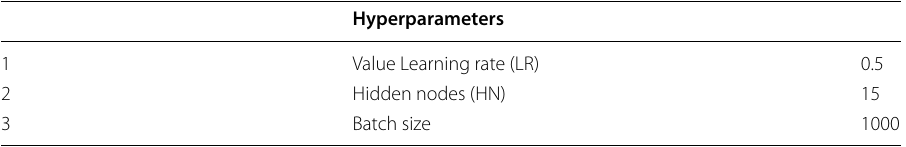
Table 12 List of hyperparameters for Deep Learning